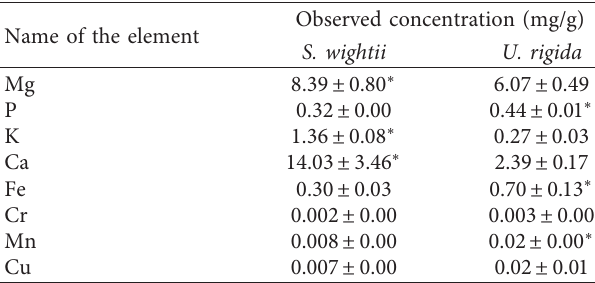
Figure 1: Functional properties of seaweeds S. wightii and U. ri gida. a Results are expressed as mean ± SD ( n � 3). Values bearing ∗ are significantly different ( p < 0 . 05) from the corresponding seaweed in an independent sample t test. Table 2: Mineral composition of S. wightii and U. rigida analyzed by